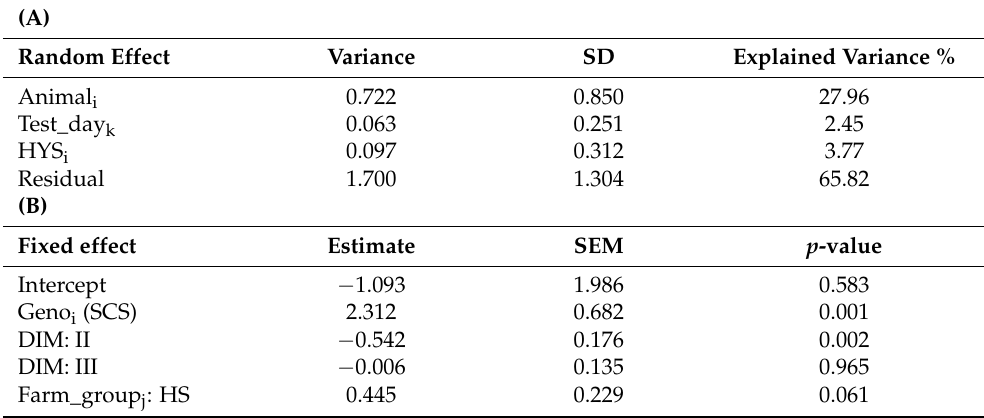
Table 3. ( A ) Random effects, variances, and standard deviations (SD). ( B ) Fixed effects estimates, standard error of the means (SEM) and significance by p -value (SCC).